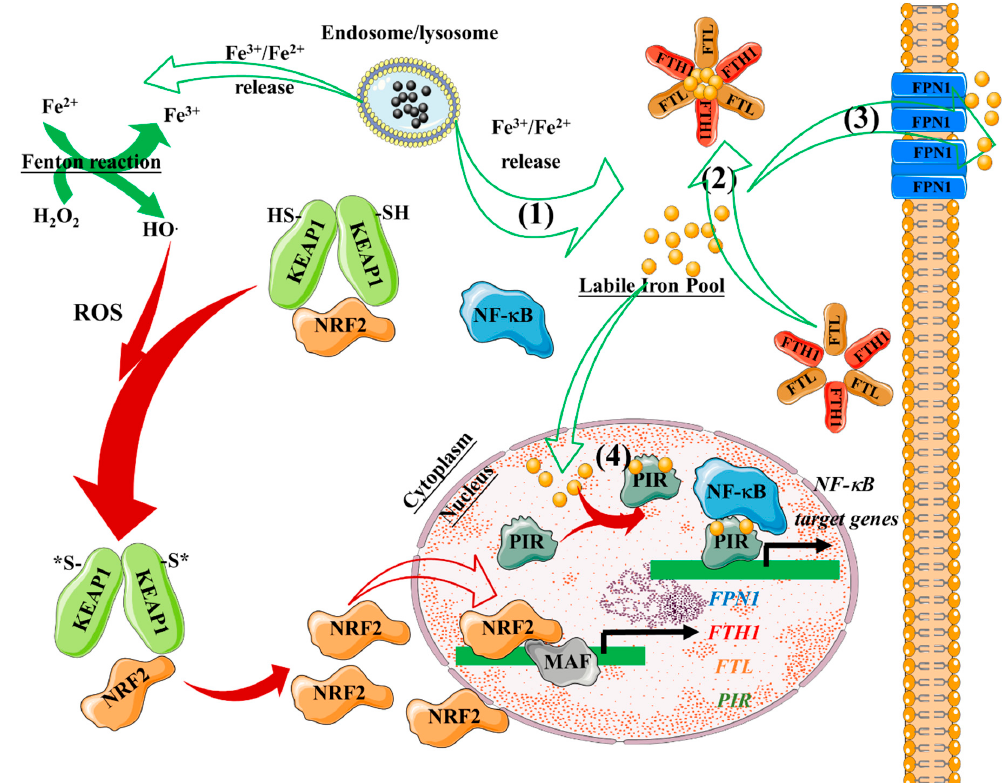
Figure 5. The ROS/Nrf2-axis regulates the labile iron pool (LIP). Iron cations are released from the endosome/lysosome ( 1 ) and Fenton reaction-induced ROS triggers NRF2 translocation to the nucleus and promotes the expression of iron metabolism-associated genes (ferroportin-1- FPN1- , ferritin heavy chain- FTH1- , ferritin light chain- FTL- , and Pirin- PIR- ). ( 2 ) Labile iron can be sequestered in ferritin, which comprises FTL and FTH1 subunits. ( 3 ) Labile iron can be exported out of the cytosol by ferroportin-1. ( 4 ) Labile iron can bind to PIR and influence NF- κ B transcriptional activity. NRF2, nuclear factor (erythroid-derived 2)-like 2; MAF, musculoaponeurotic fi brosarcoma.